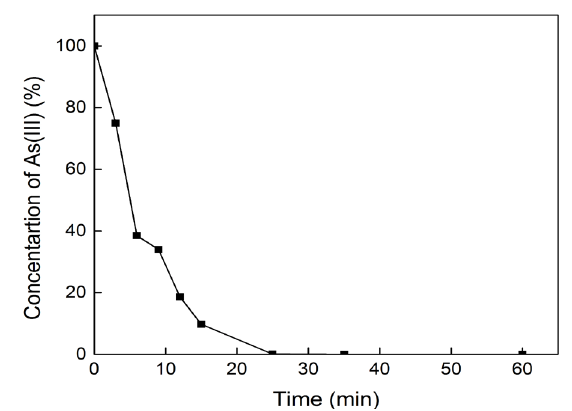
Fig. 2. Effect of oxidation time at low initial concentration (50mg/l), pH 1 and T-20°C